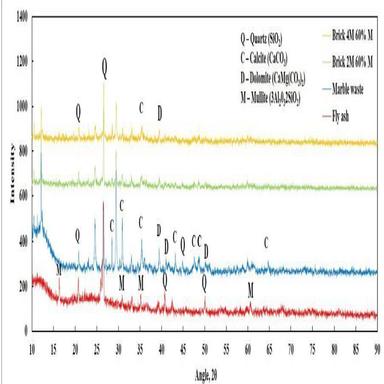
XRD diffractograms obtained for hybrid geopolymeric composite samples prepared at different molarities and 60% marble waste content.